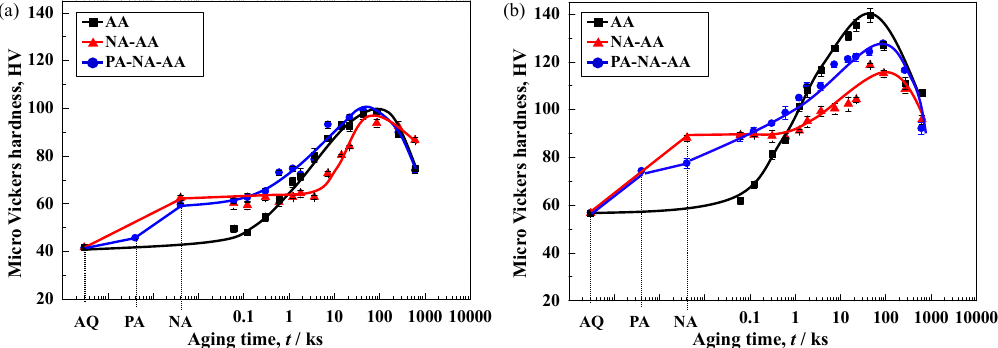
Figure 3. Hardness during aging at 170 ◦ C with the different heat treatments in ( a ) 3M10S and ( b ) 9M10S. AQ, PA, NA and AA stand for as-quenched, pre-aging at 100 ◦ C for 3600 s, natural aging at room temperature for 7 days, and artificial aging at 170 ◦ C,